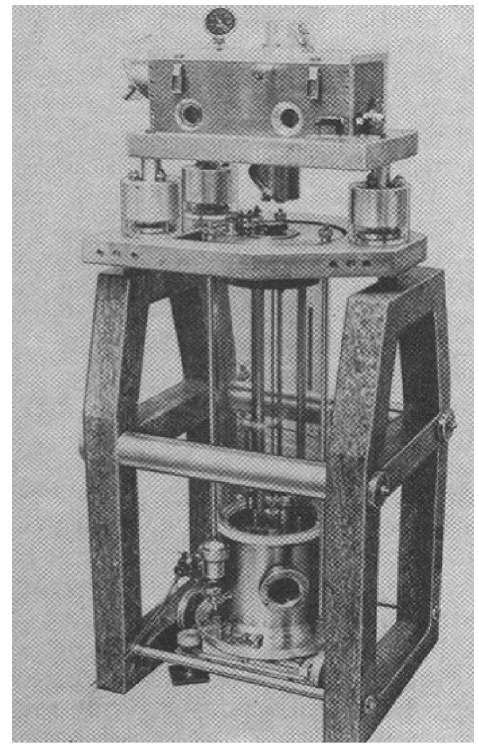
Fig. 1. First version of the IMGC absolute gravimeter.